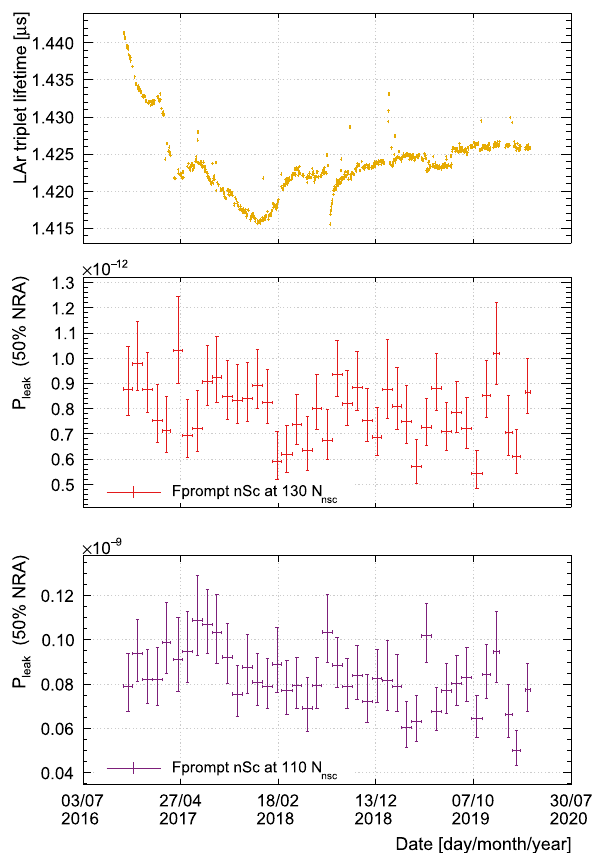
Fig. 8 The upper two figures show the time evolution of the leakage probabilities at 110 N nsc and 130 N nsc for F nsc prompt at 50% NRA. The triplet lifetimes in the third figure are determined by using the full math- ematical model of the 39 Ar scintillation pulse shape [22]. The observed triplet lifetime strongly depends on the state variables of the detector, e.g. temperature, pressure, or impurities diffused from the detector into the liquid argon. A change in the triplet lifetime is expected to influence the shape of the PP distribution and hence causes the PP distribution of the whole data set to be a superposition of distributions with slightly different parameters